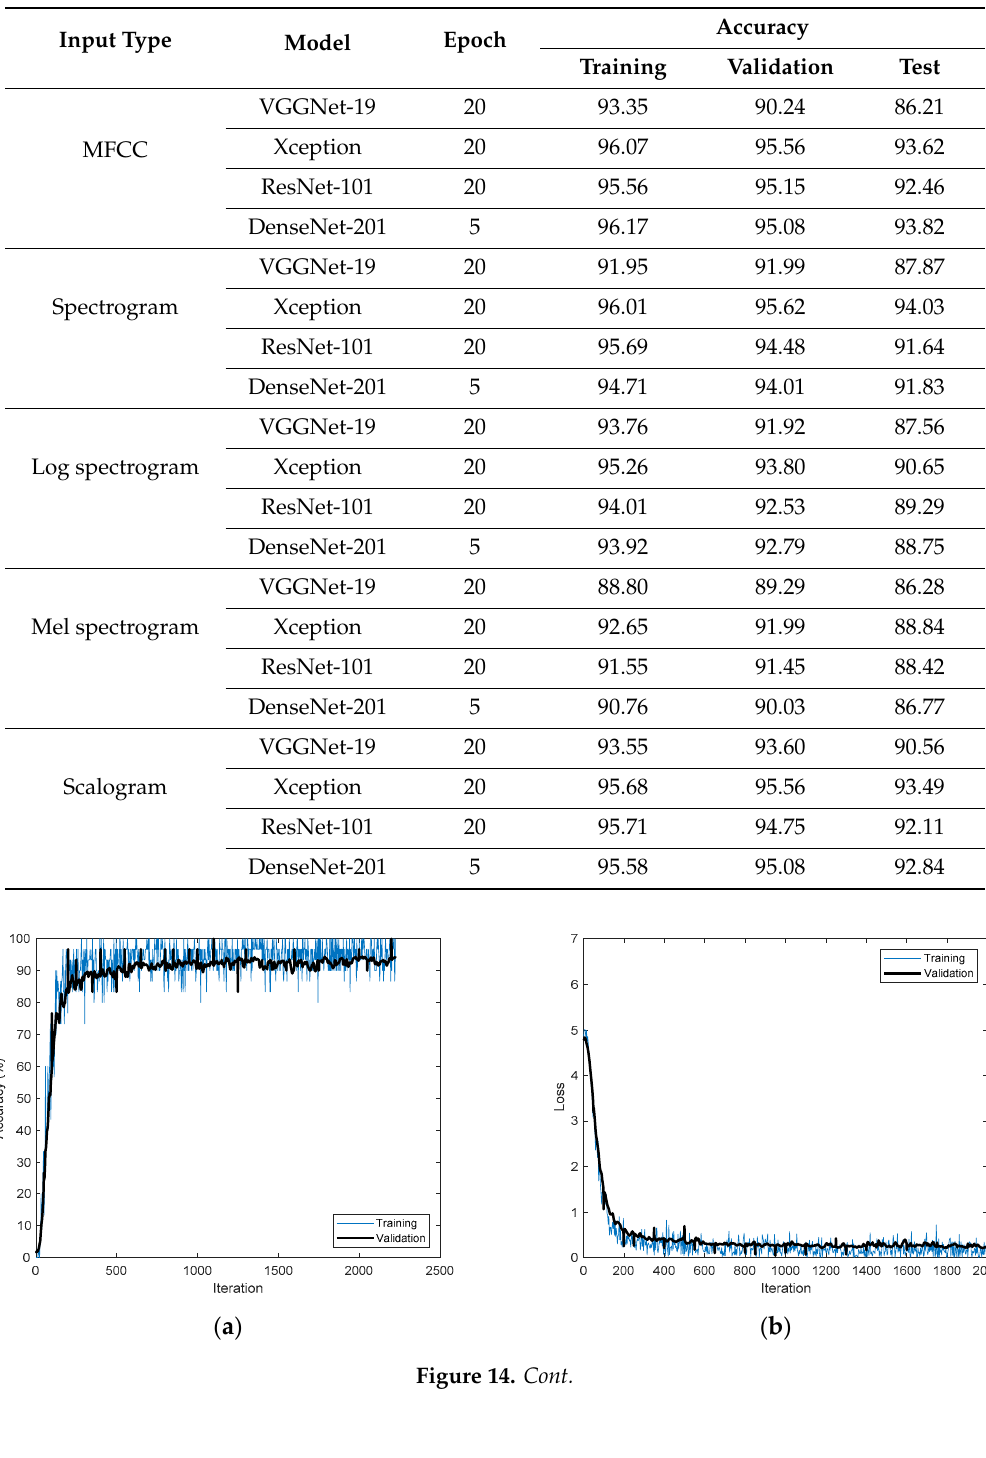
Table6. AccuraciesachievedbyvariousmodelsbasedontheCNNusingtime-frequencyrepresentations on CU-ECG.